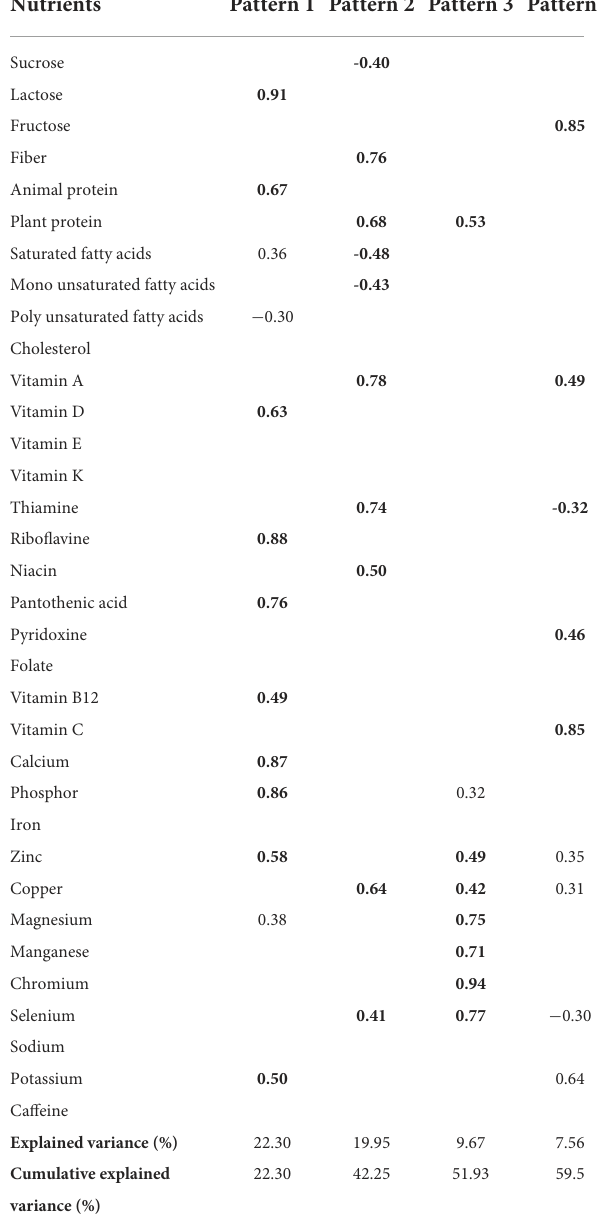
TABLE 1 Factor loading matrix and explained variances for major nutrient patterns identified by factor analysis in 225 cases and 450 controls *†